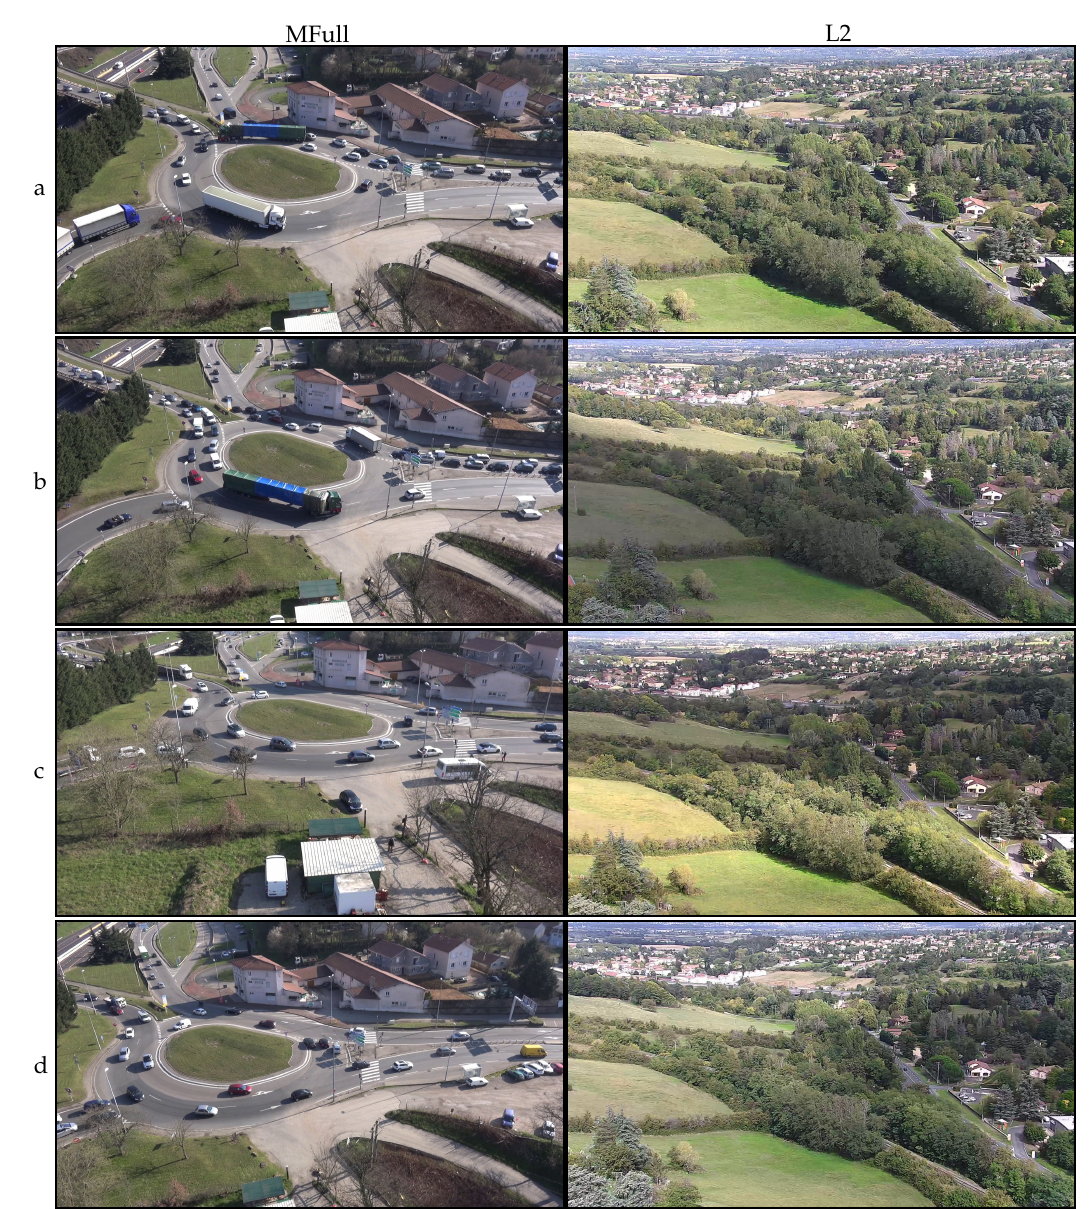
Figure 1. Images extracted from the one hour-long MFull ( left column ) and the two hours-long L2 ( right column ) sequences in our database, described in Section 5.1. ( a ): reference frame. ( b , c ): intermediate frames. ( d ): frames picked near the end of the sequence.